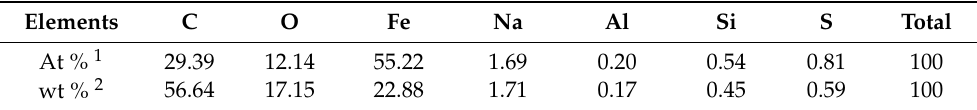
Table 3. Laser welding parameters.